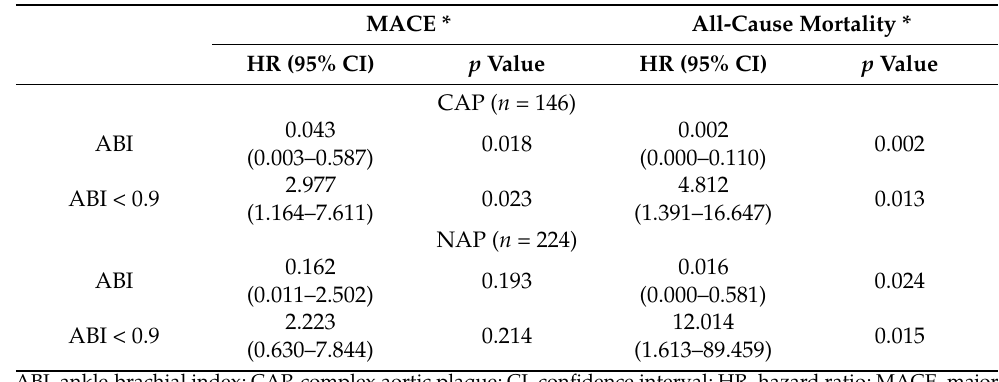
Table 3. Multivariable Cox regression analysis of long-term outcomes according to the characteristics of arteriogenic embolism.